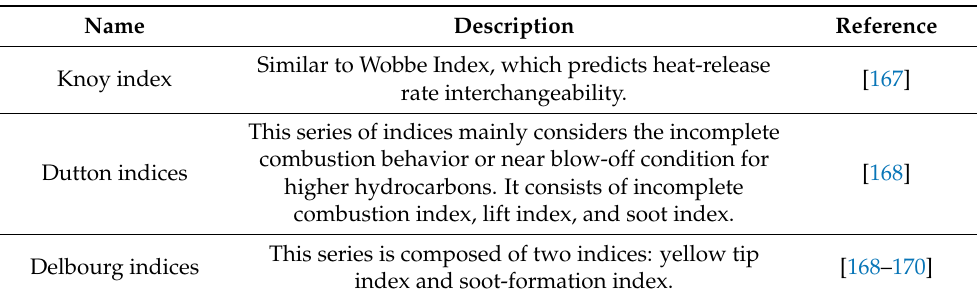
Table 14. Flame indices besides AGA and Weaver